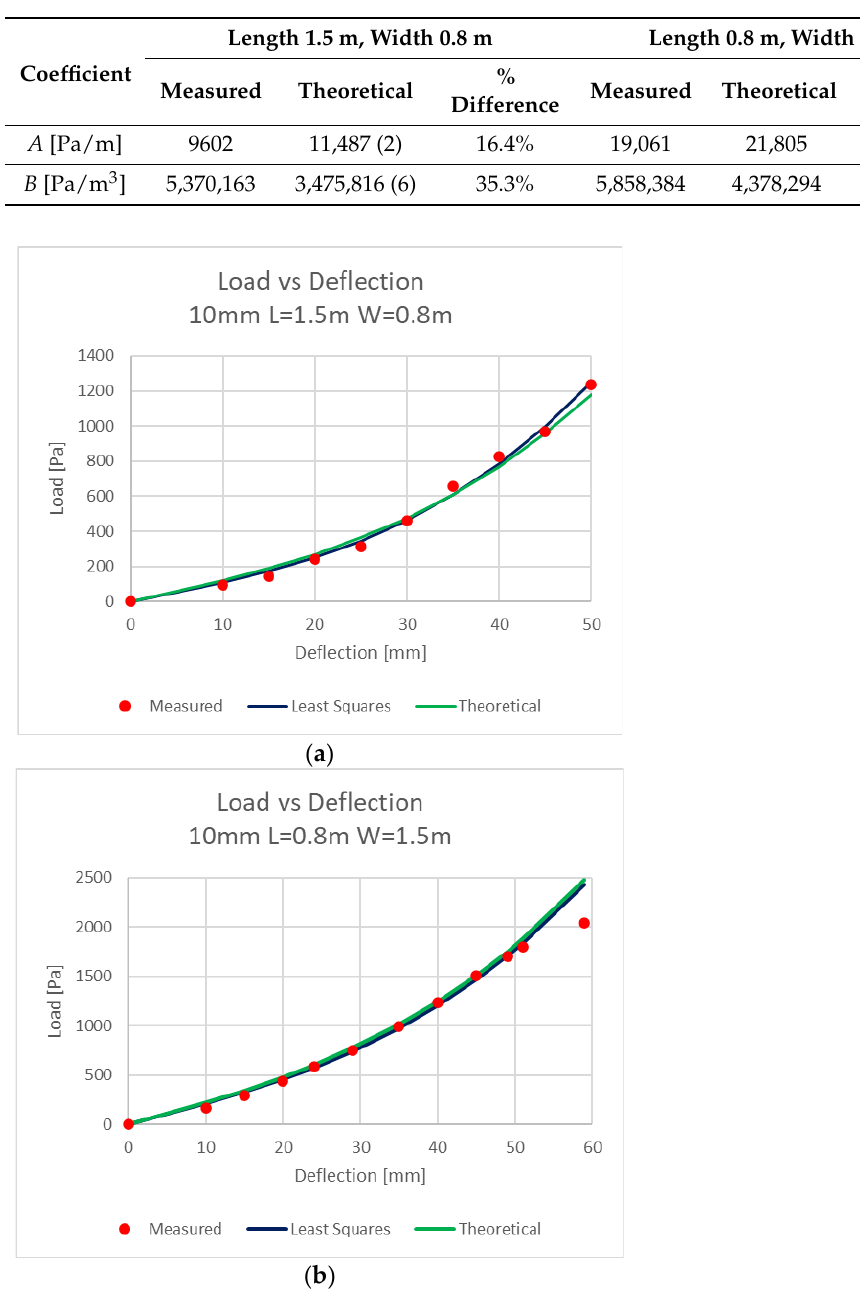
Table 2. Coefficients results.